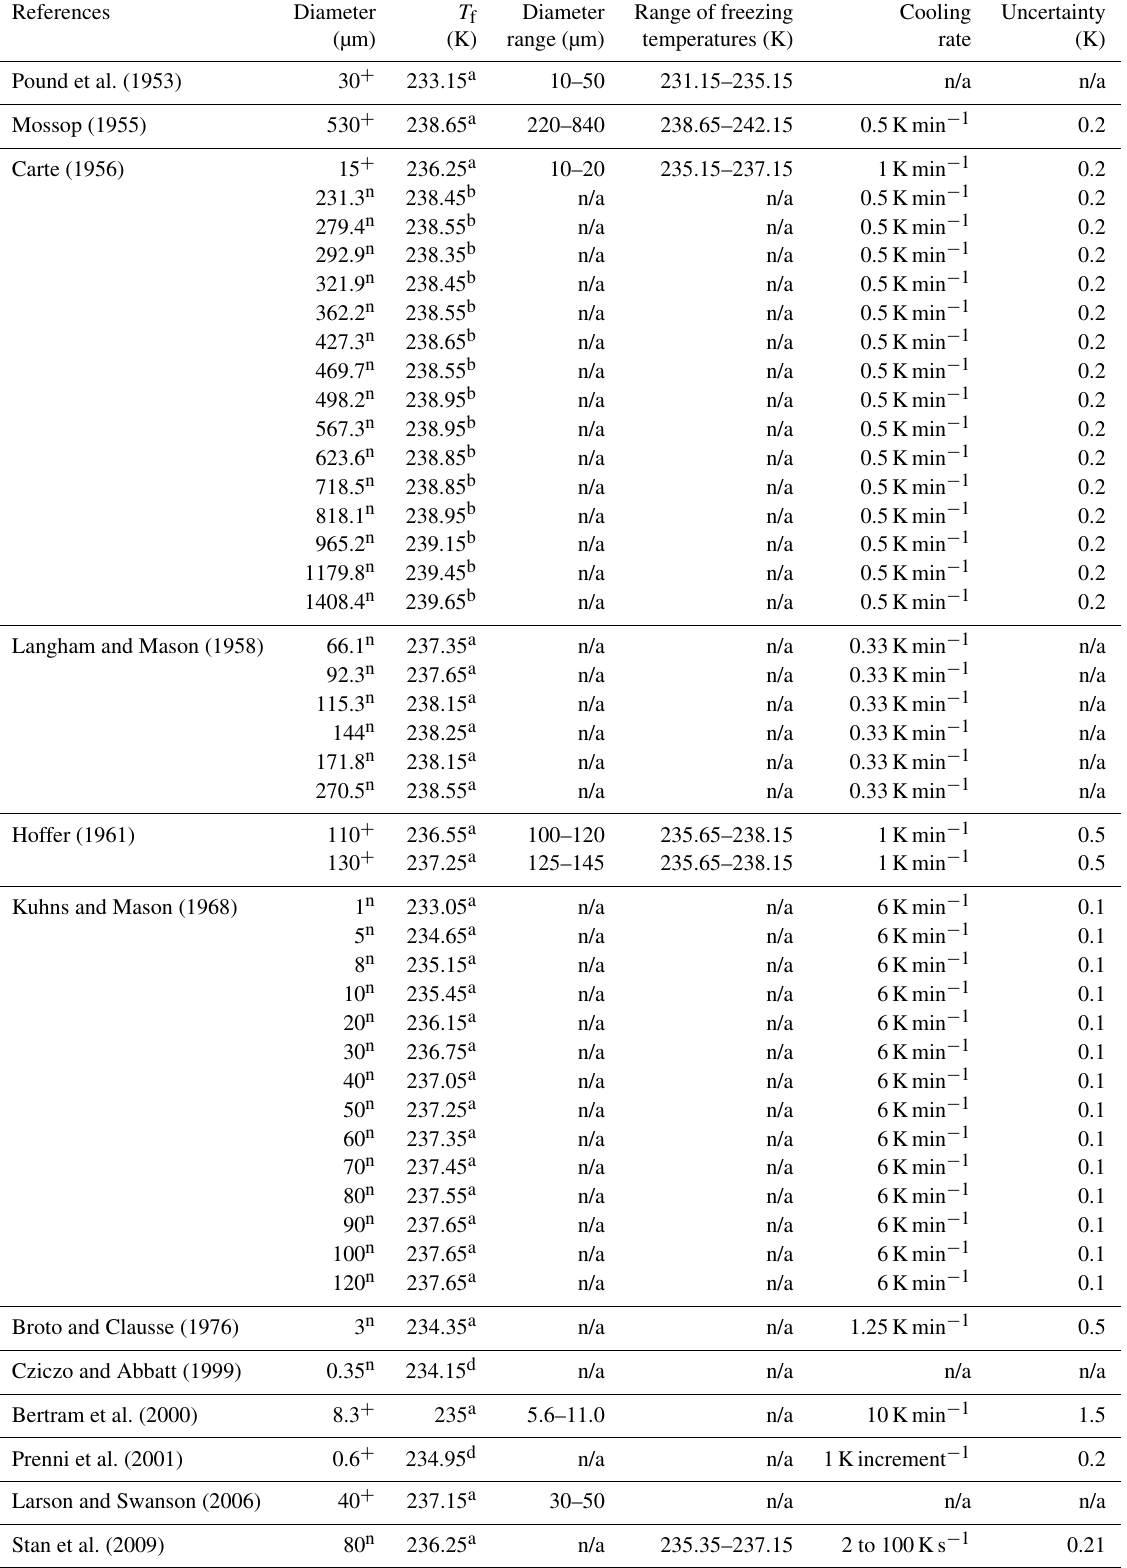
Table 1. Information regarding the details of the homogeneous ice nucleation experiments used in the comparison, including the size, the freezing temperature, and the cooling rate and uncertainty of the